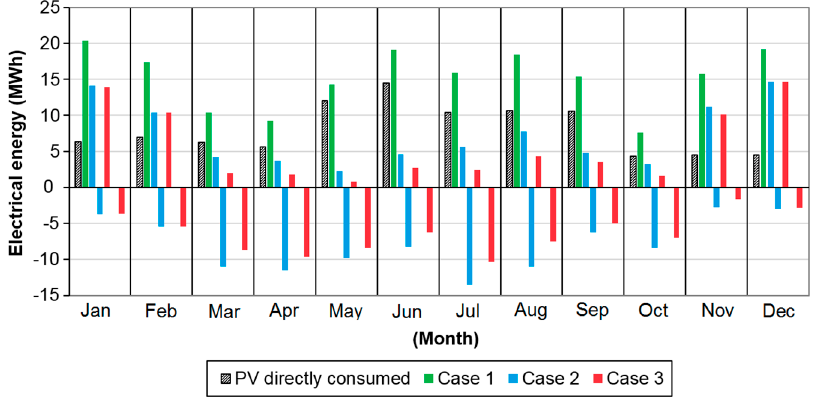
Figure 11. Yearly electricity balance in the different cases considered in the study (Positive axis: imported electricity from the grid (E Grid > 0); Negative axis: exported electricity to the grid (E Grid < 0)).